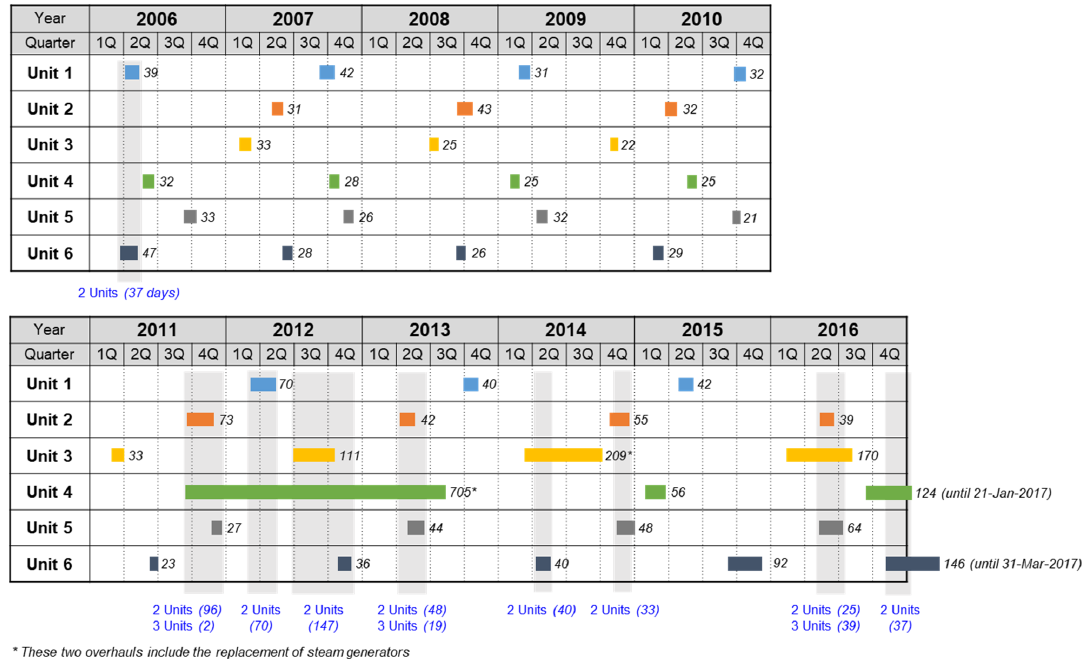
Figure 7. Refueling outage experience of Hanul Units 1–6 during 2006–2016.